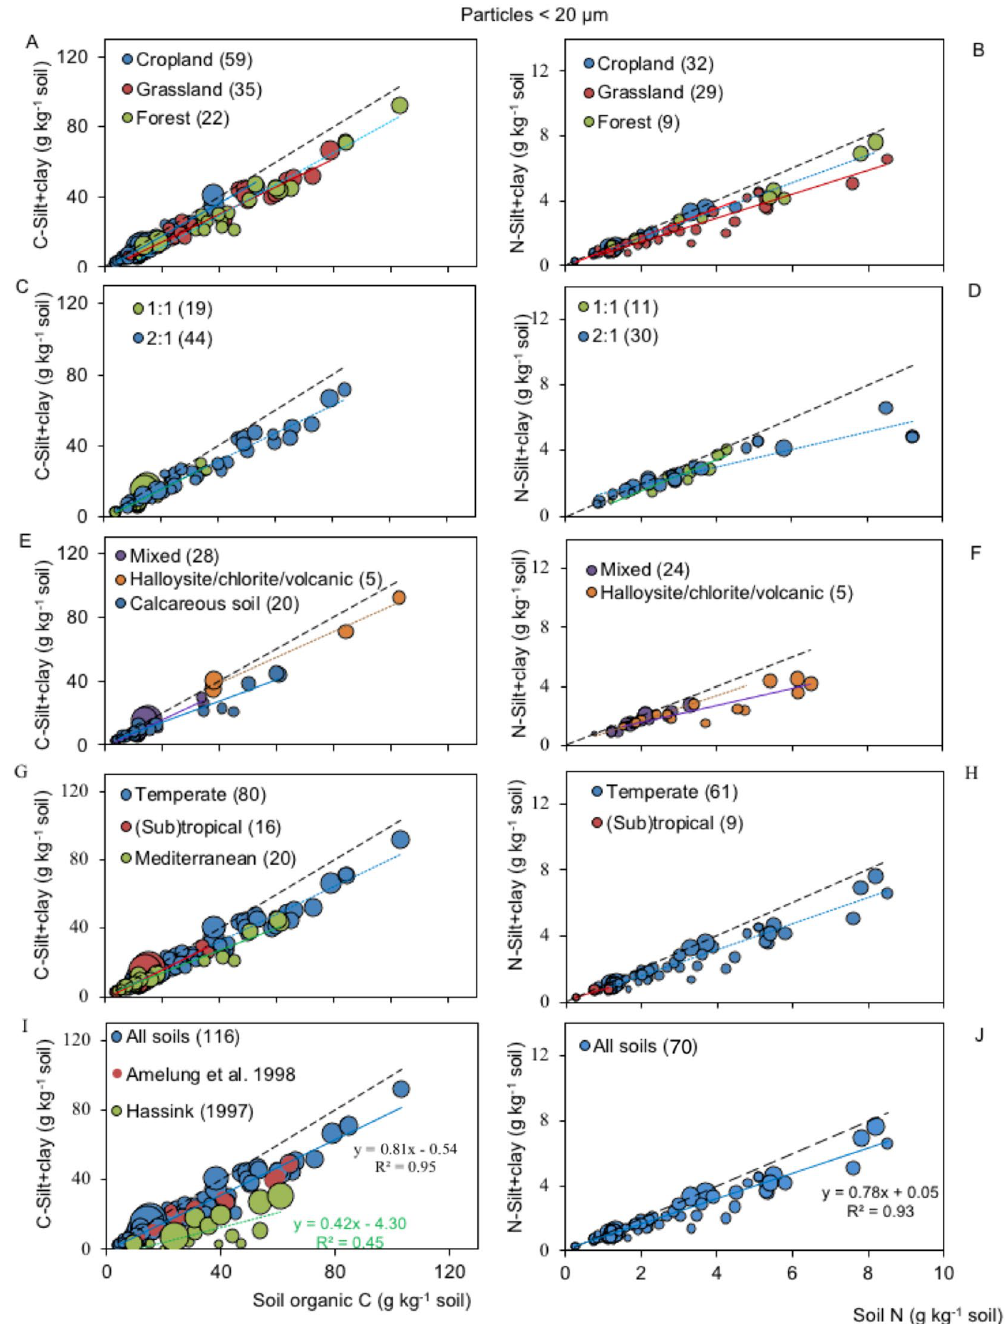
Figure 4. Relationship between soil organic carbon (SOC) content and C-silt + clay particles < 20 µm (n = 116) or total nitrogen and N-silt + clay < 20 µm (n = 67), grouped by ( A , B ) land use ( C – F ) clay mineralogy, ( G , H ) climate and ( I , J ) all soils. Native grassland soils (n = 21) from Amelung et al. 70 used as ultrasonic reference method and Dutch soils used to estimate the protective capacity of Hassink 23 are also shown. The greater bubble size indicates high weight with lower standard errors. Long segmented line stands for 1:1. Short segmented or solid line stands for regression fitting to each categorical